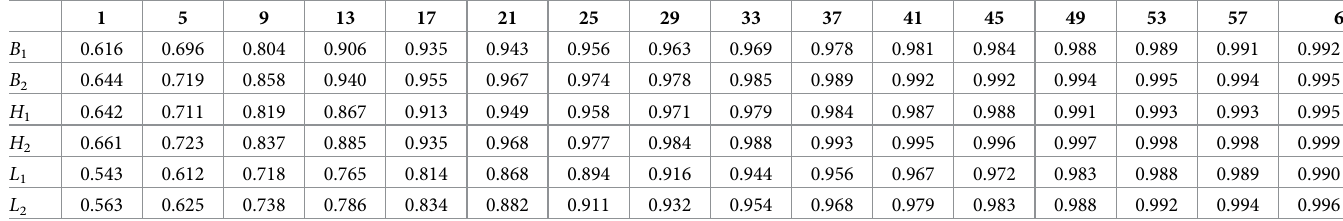
Table 2. The degree of approximation OD with different interceptive value n .